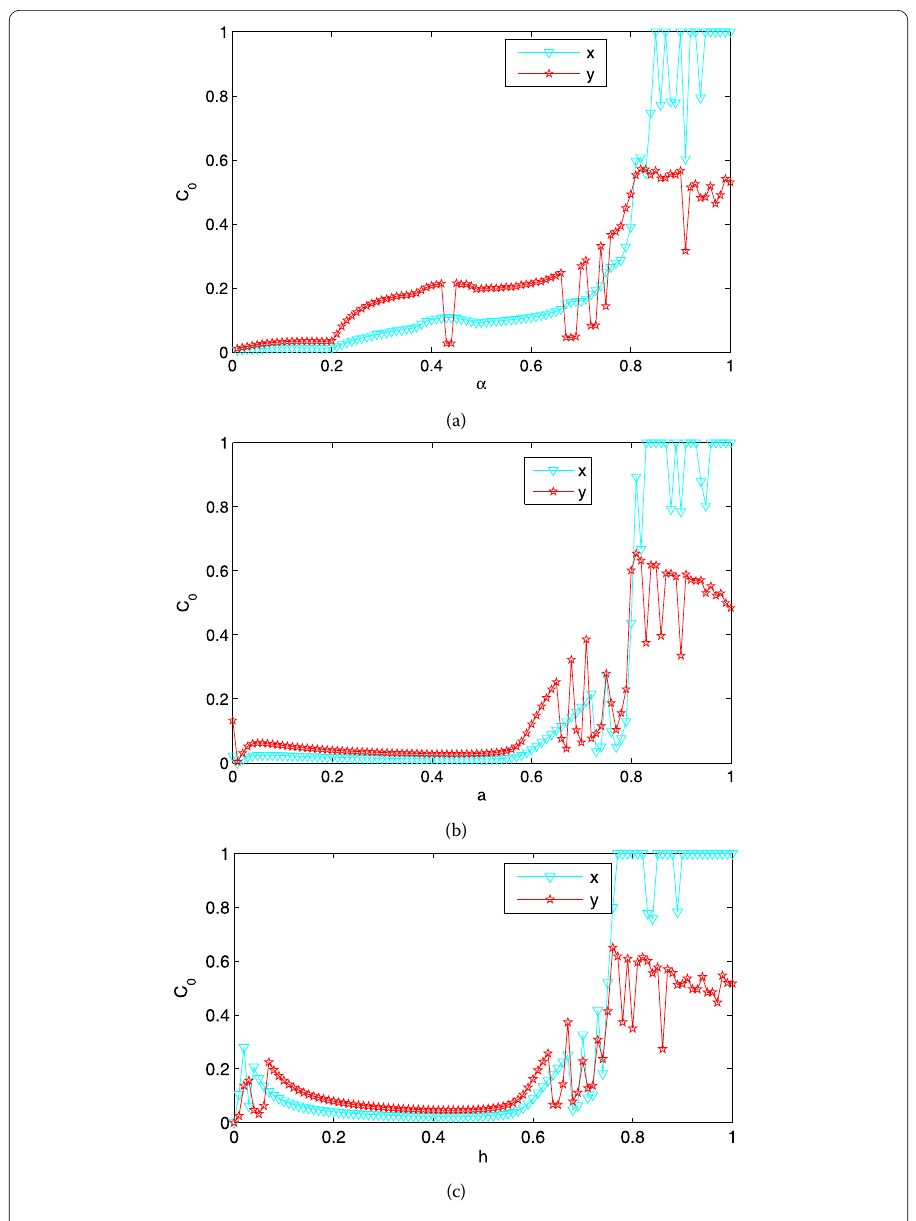
Figure 6 C 0 complexity. ( a ) The C 0 complexity of system (11) with a = 1, h = 0.95, and α ∈ (0,1]. ( b ) The C 0 complexity of system (11) with α = 0.95, h = 0.95, and a ∈ [0,1]. ( c ) The C 0 complexity of system (11) with α = 0.95, a = 1, and h ∈ (0,1]